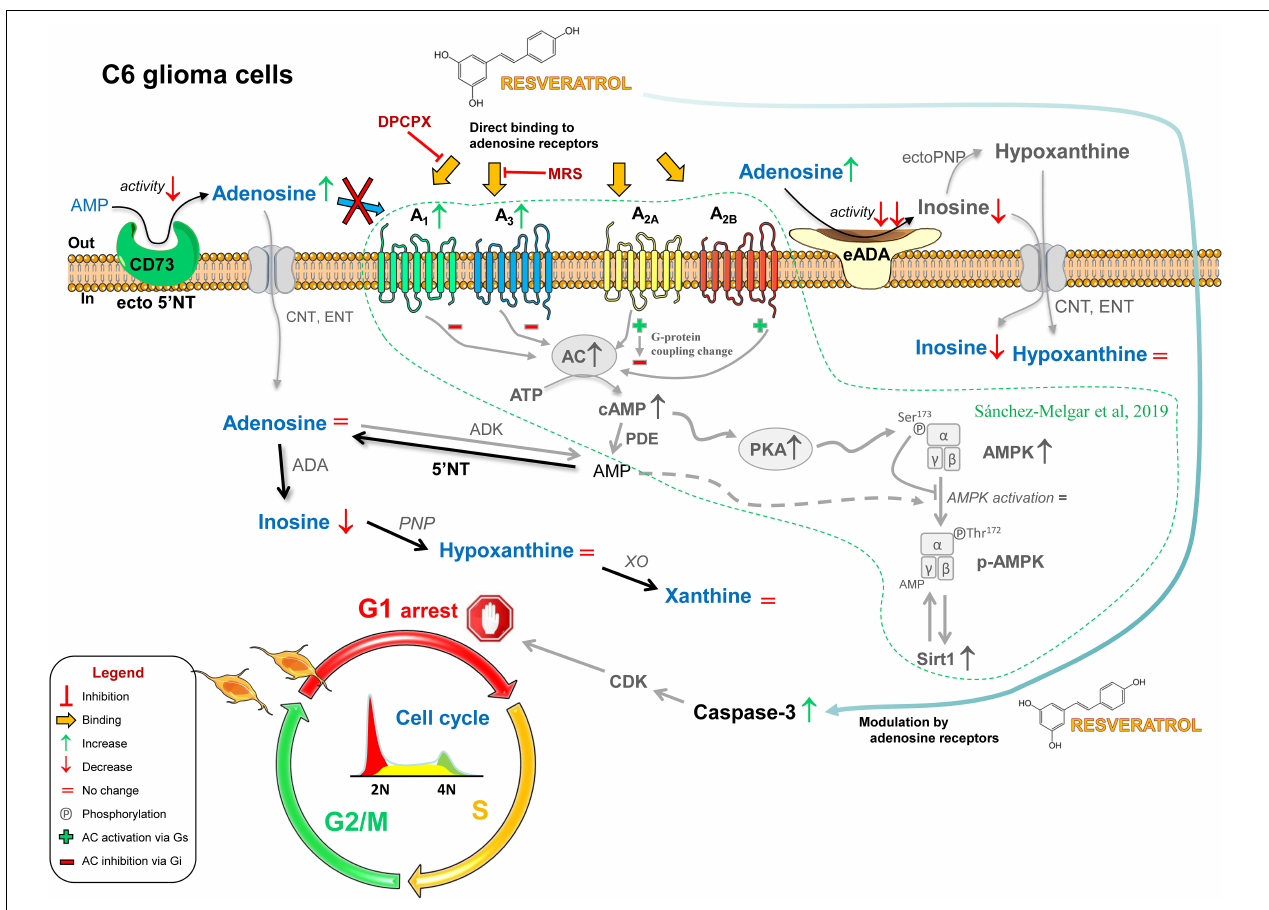
FIGURE 10 | Possible role of adenosinergic signaling in the antitumoral effect of RSV. The exposure of C6 glioma cells to RSV causes the decrease ( ↓ ) or the increase ( ↑ ) of several compounds and proteins that ultimately lead to cell cycle arrest in the G 1 phase. RSV upregulates A 1 and A 3 receptors; changes G-protein coupling of A 2 A receptor from activation (Gs, +) to inhibition (Gi, − ) of adenylate cyclase (AC) activity; upregulates AC, increases basal AC activity, and upregulates protein kinase A (PKA); higher levels of cAMP inhibit AMPK activation via PKA-mediated phosphorylation (Ser 172 ); reduces adenosine-converting enzymes (i.e., CD73 and ADA), leading to increased extracellular levels of adenosine; caspase-3 is activated as a result of the direct binding of RSV to adenosine receptors and the modulatory action of these receptors on other RSV-elicited pathways, leading to CDK-mediated cell cycle arrest in the G 1 phase. Previous results reported by our group in these cells are shown in gray and surrounded by a dotted